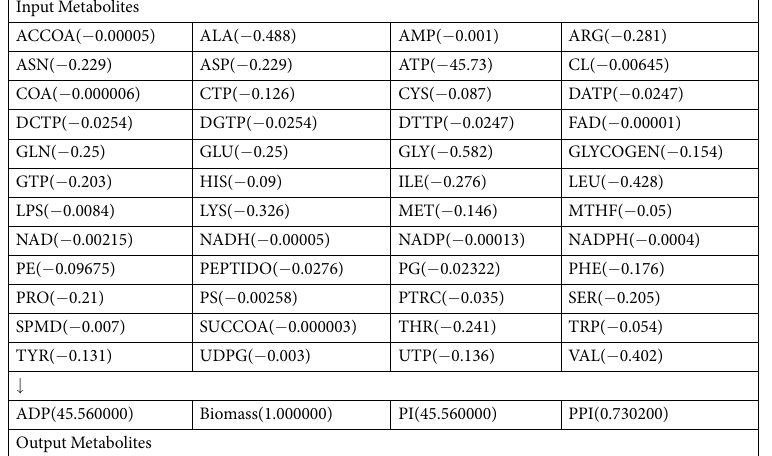
Table 1. An example of the non-integer coefficients, in parentheses, of the input and output metabolites of the E . coli metabolic model iJR904 growth reaction 36